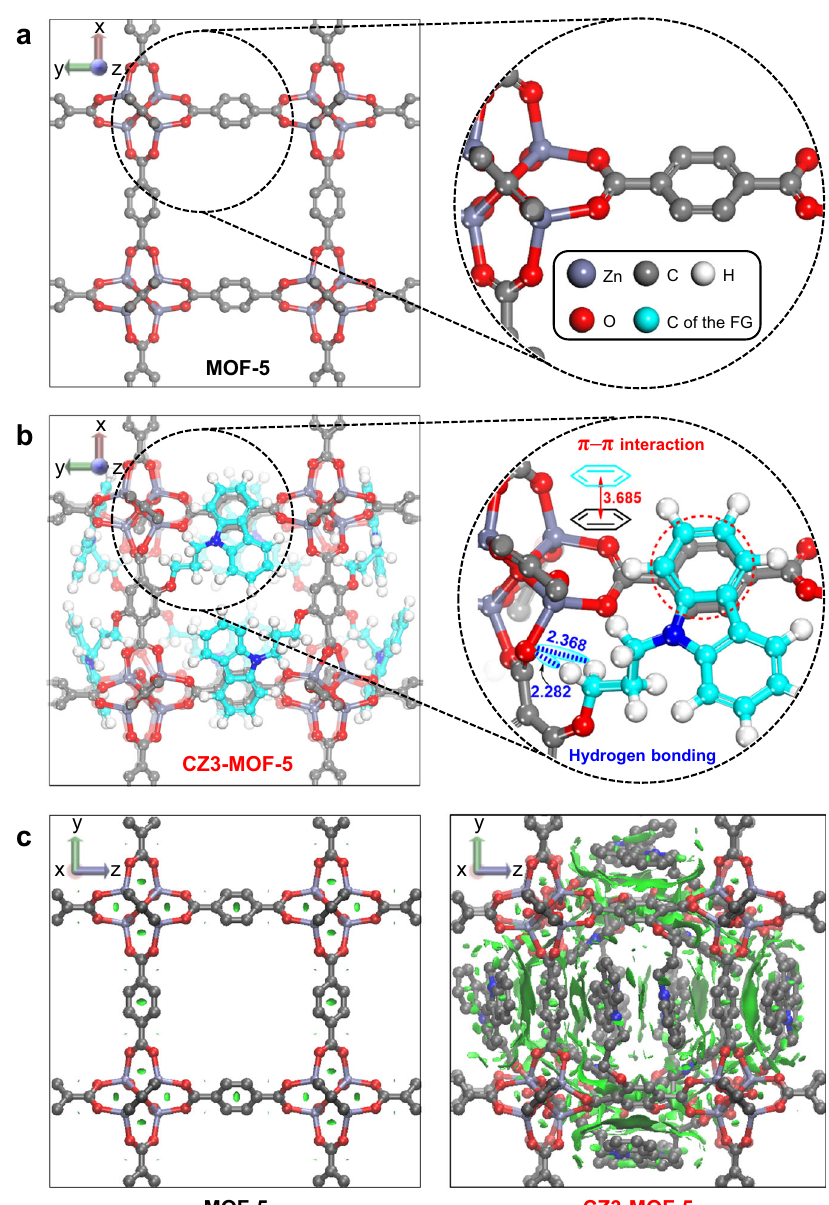
Fig. 3 Computed structures in a unit cell. a MOF-5. b CZ3-MOF-5. c Non-covalent interaction (NCI) plots of the MOF-5 and the CZ3-MOF-5. All bond lengths are in Å. The surface of the NCI interactions is colored on a green scale. Non-essential hydrogens are not